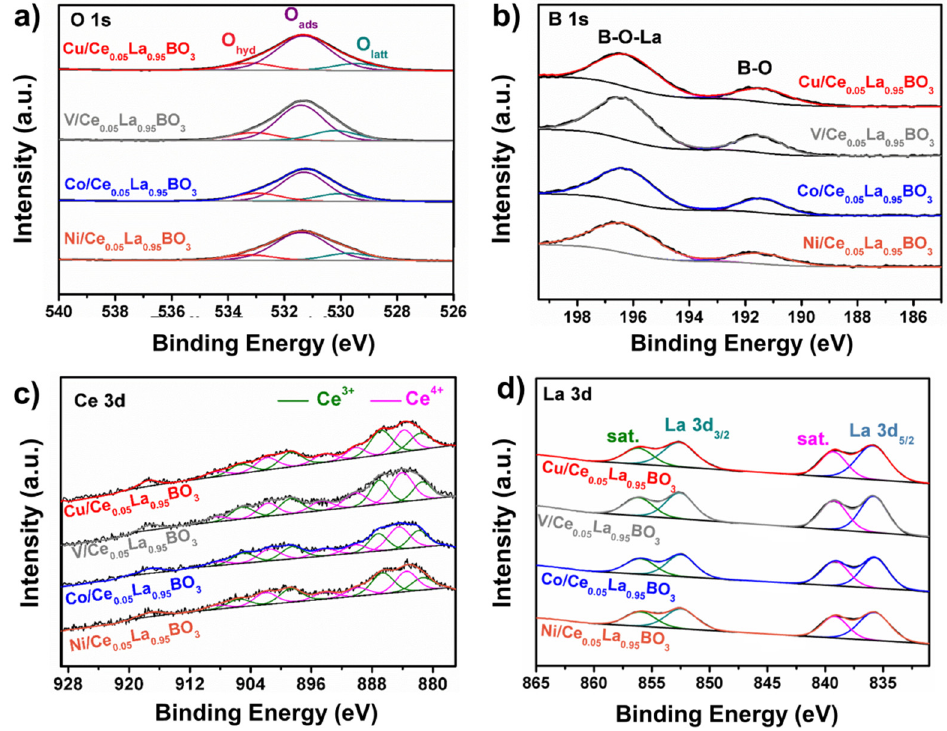
Figure 4. High-resolution XPS scans of different catalysts: ( a ) O 1s, ( b ) B 1s, ( c ) Ce 3d, and ( d ) La 3d.